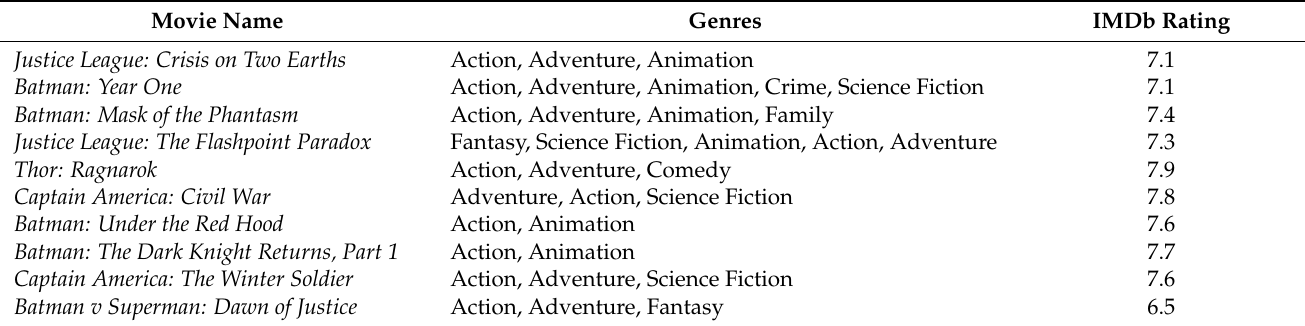
Figure 7. Relation between combined score with similarity score andpredicted rating.